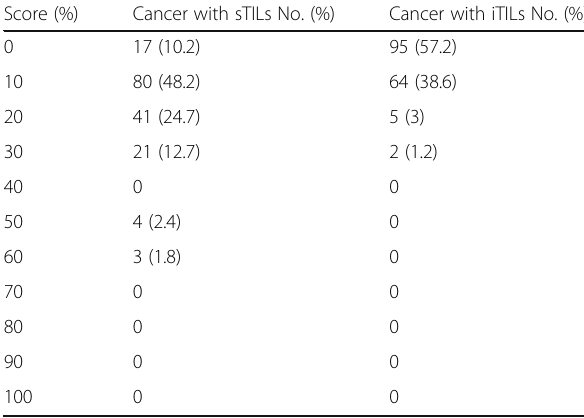
Table 2 The distribution of TILs scores in